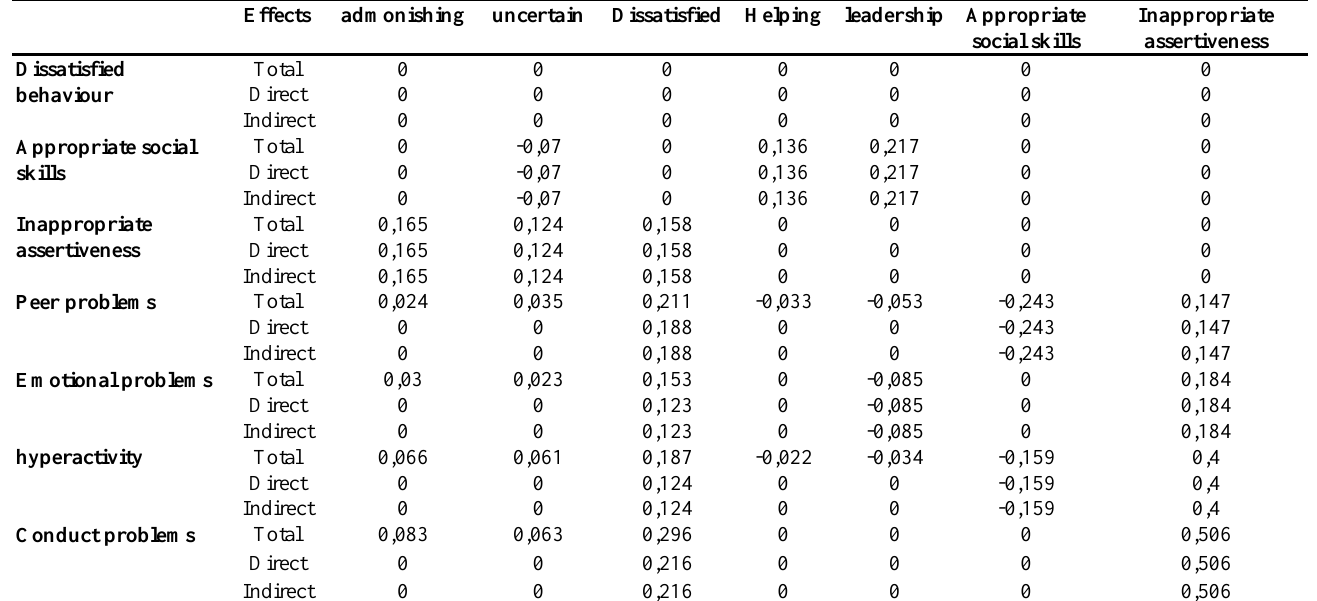
Standardized effects (Direct, Indirect,